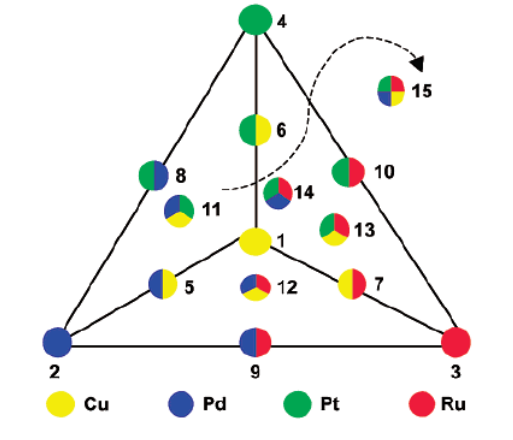
Figure 7. Experimental schematic of the different combinations of monometallic, bimetallic, tri-metallic and multi-metallic nanoparticles synthesized. Reprinted (“adapted” or “in part”) with permission from [38], © 2002 American Chemical